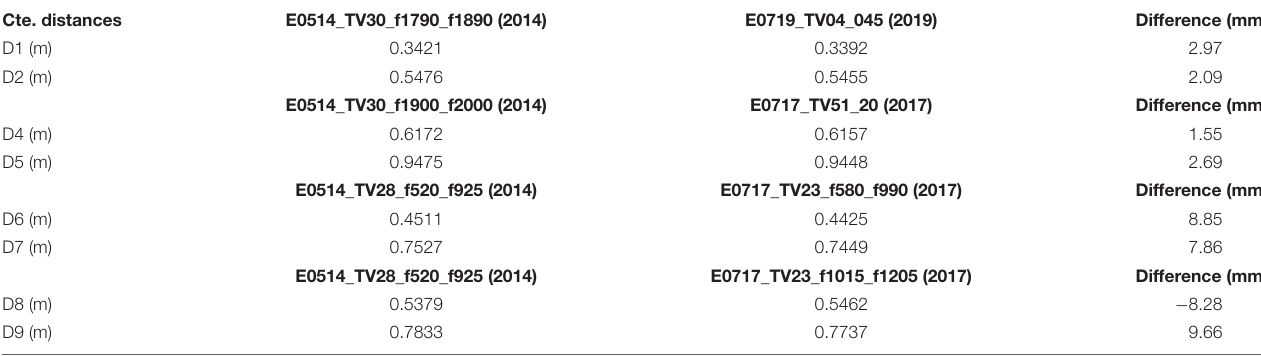
TABLE 2 | Independent measurements between 3D models to get the uncertainty of the data. Cte. distances